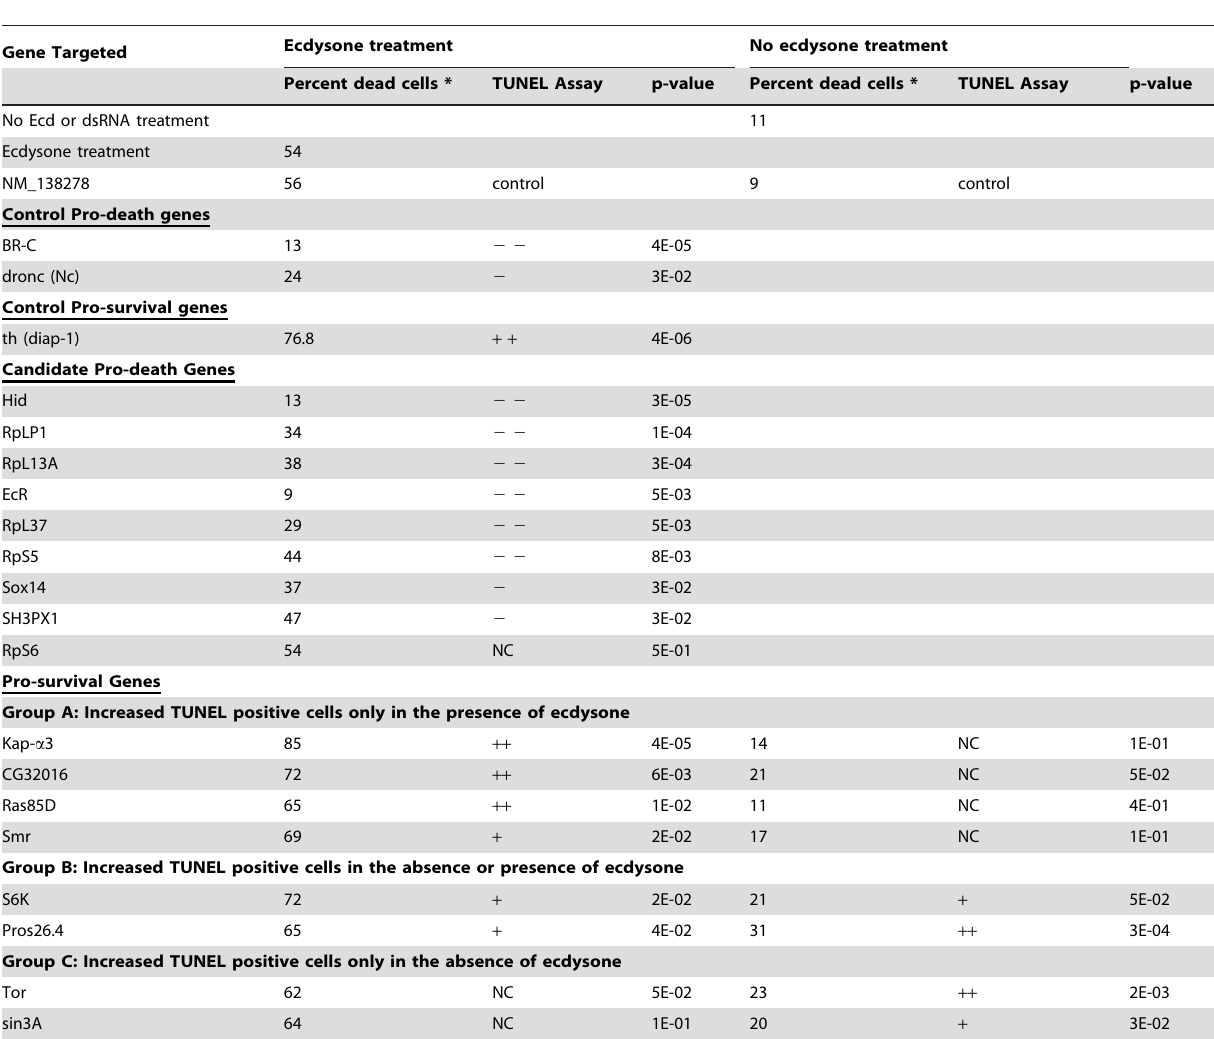
Table 2. Ecdysone dependent and ecdysone independent death-related effects identified by the TUNEL assay.